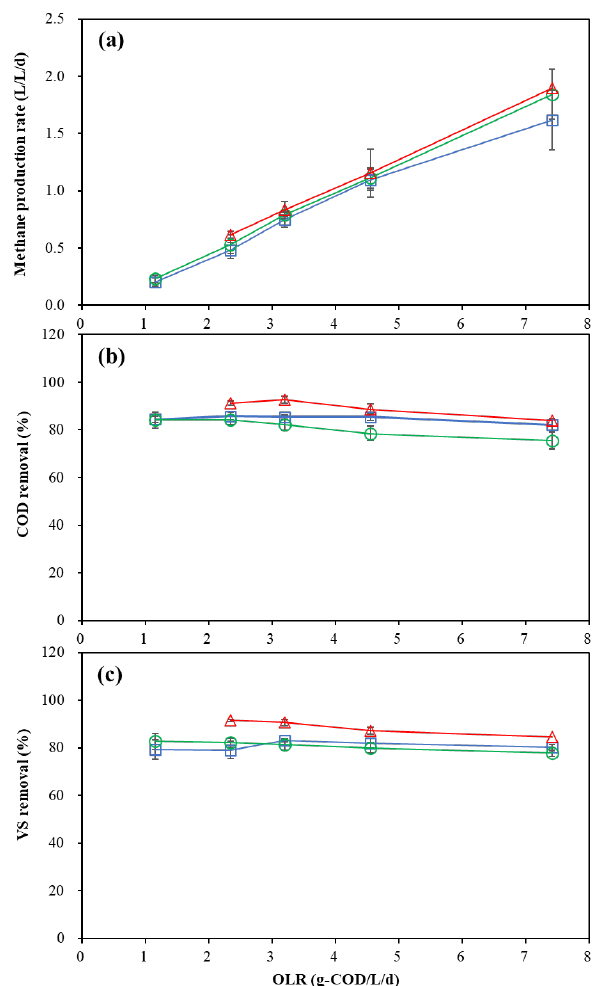
Figure 3. Effects of OLRs on ( a ) methane production, ( b ) COD removal, and ( c ) VS